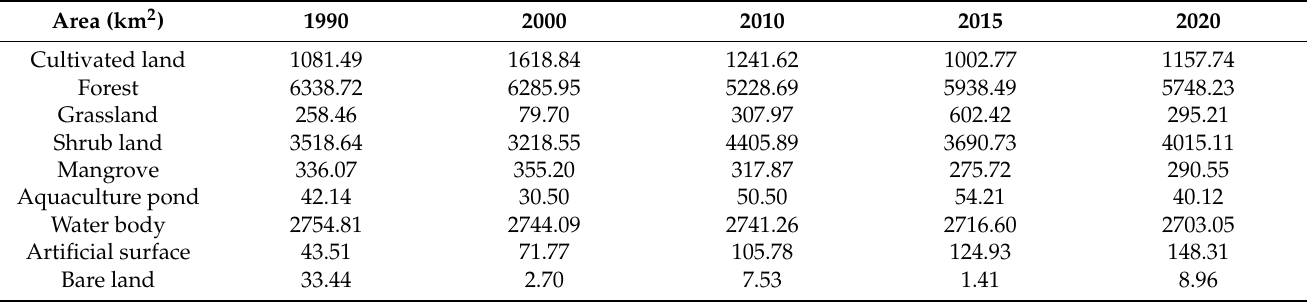
Table A3. Area statistics of land cover types in Palawan Island between 1990 and